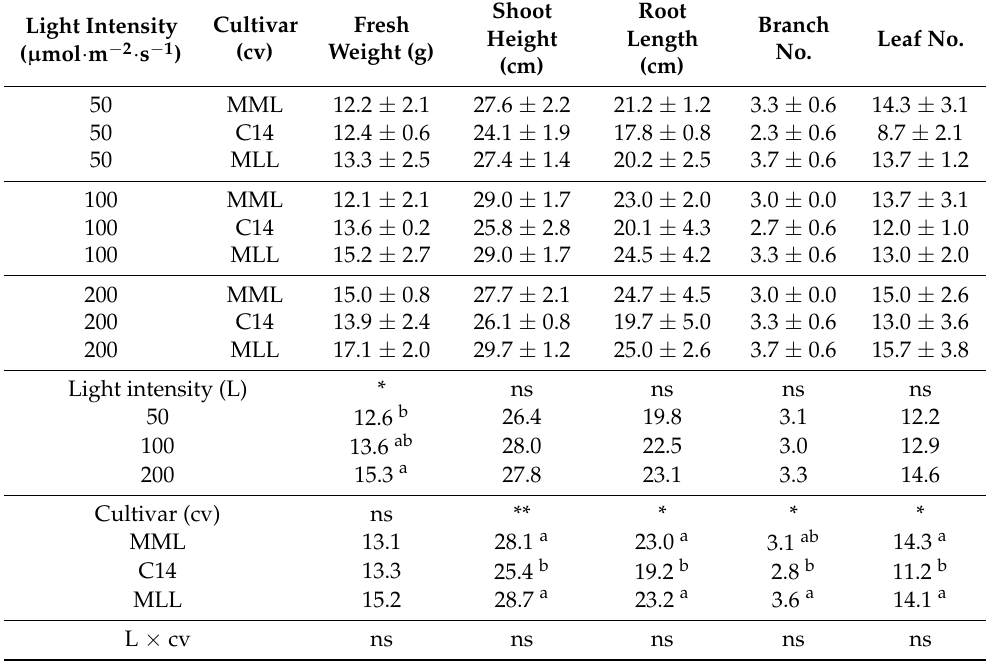
Table 2. Effect of different light intensities and cultivars on shoot length, branch number, leaf number, root length, and fresh weight of mulberry plants exposed to artificial light for seven